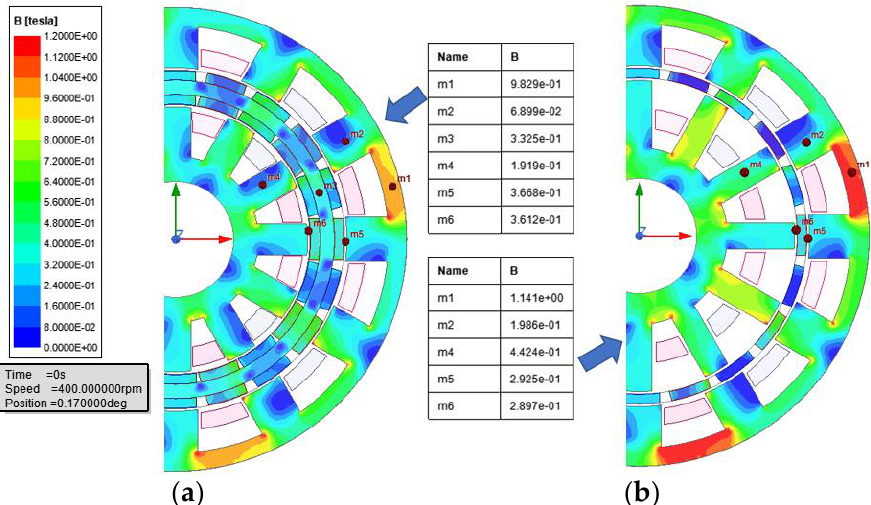
Figure 7. Flux densities comparison in DARF-PMVM at load: ( a ) with iron yoke rotor, ( b ) without iron yoke (yokeless) rotor.